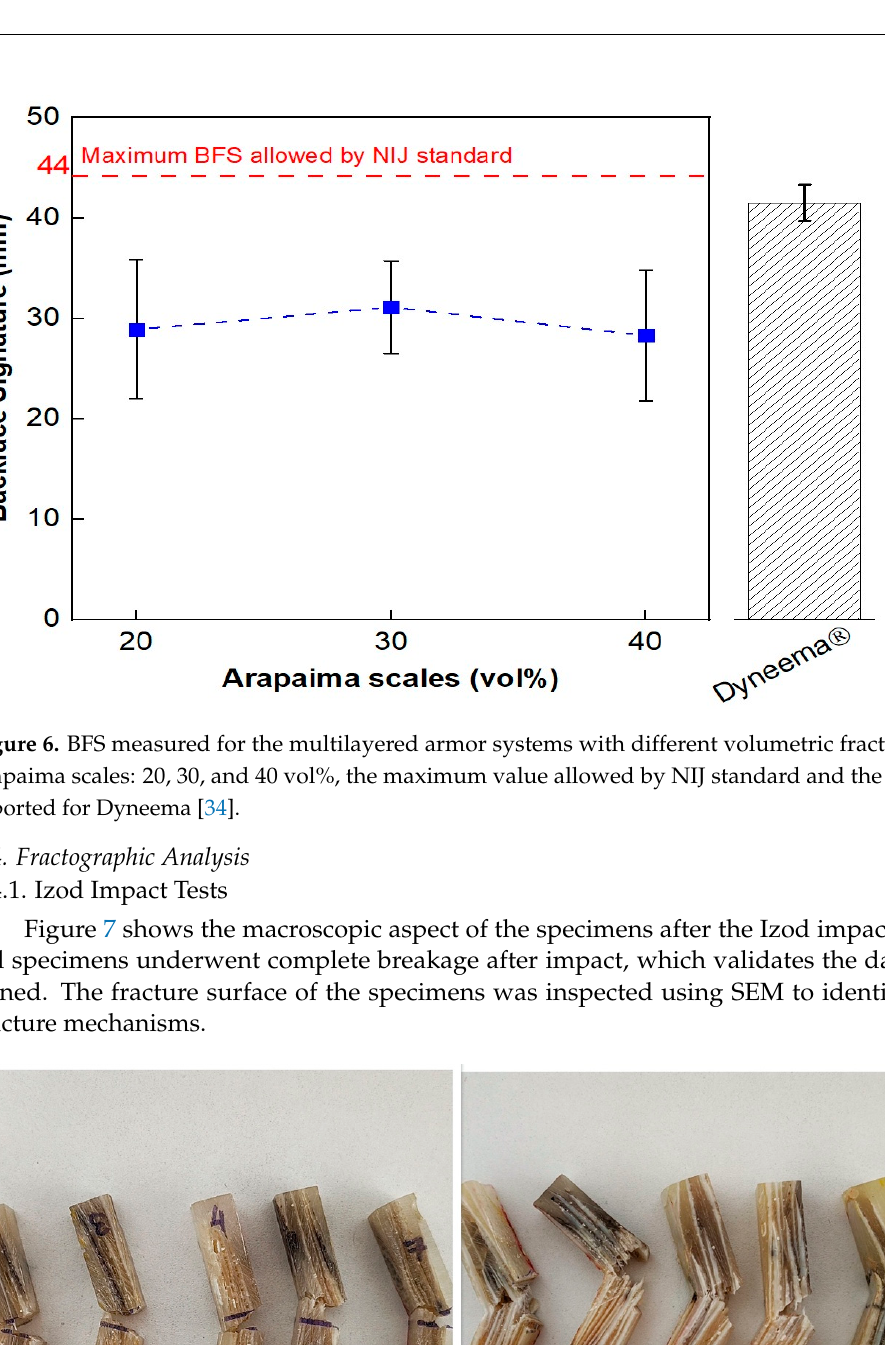
Figure 8. SEM image of the fracture surface of the composite with 20 vol% of arapaima scales after the Izod test with magni fi cations of: 50× ( a ) and 1000× ( b ). Figure 8b depicts, with greater magni fi cation, the scales in the composite. In this fi g- ure, one can observe the mechanisms of deformation and fracture present in the reinforce- ment. It is also possible to observe the breakage of the collagen fi bers oriented normal to the fracture plane. Concomitantly, it is also observed: rotation, delamination, and rupture of the fi bers in the lamellae oriented parallel to the fracture plane, which were reported in previous studies in quasi-static mechanical tests of the individual scales [20,21,23–25]. In